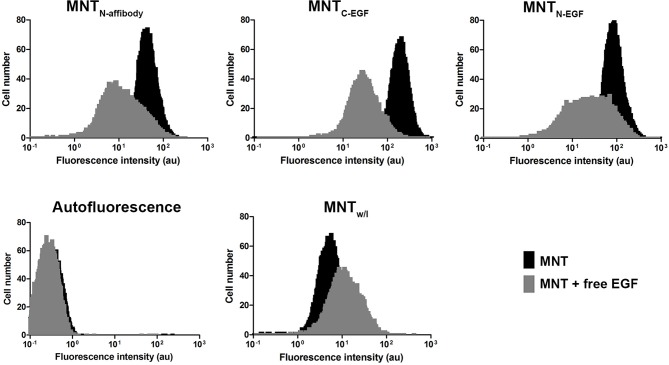
Intracellular accumulation of Alexa 647 labeled MNT measured by flow cytometry. Flow cytometry histograms of A431 cells, cells incubated with MNTN-affibody, MNTN-EGF, MNTC-EGF or with control MNTw/l for 18 h with or without free EGF (2 μM). Untreated cells served as autofluorescence controls. Error bars represent standard errors of mean (n = 4).